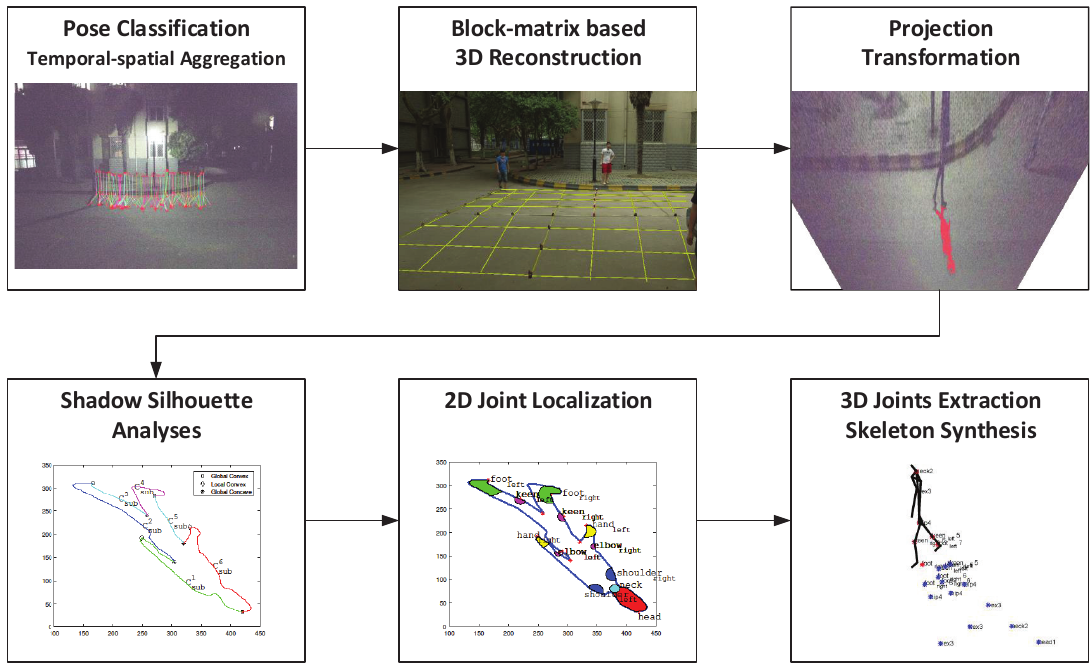
Figure 5. The flow chart of skeleton synthesis procedure based on